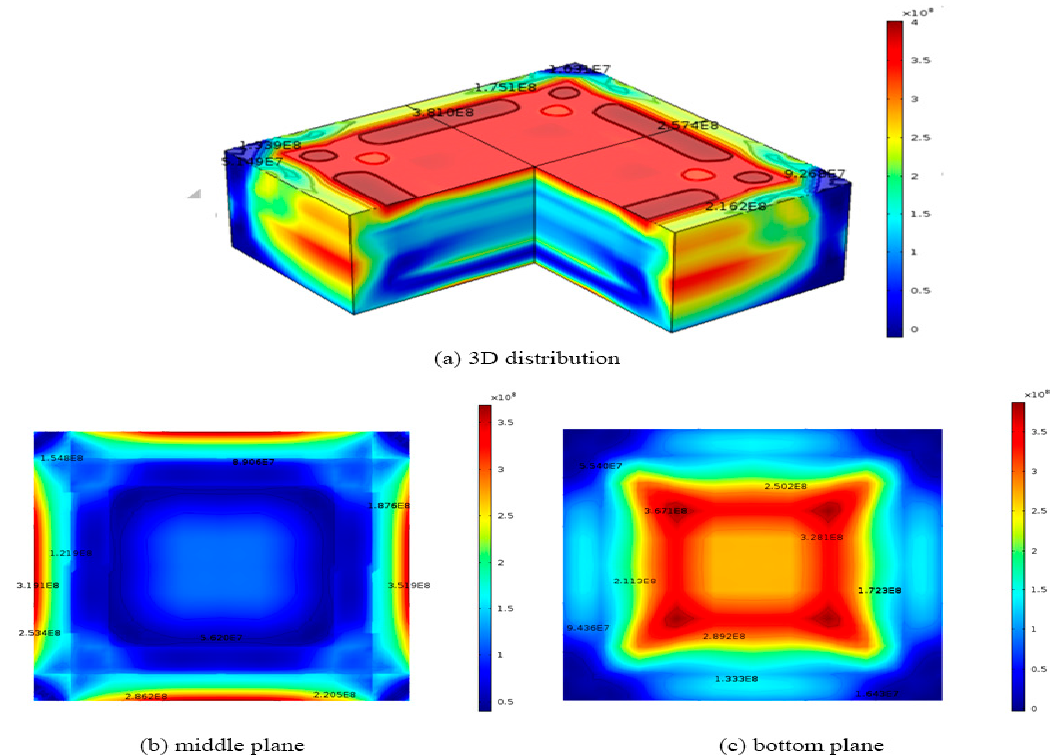
Figure 4. Dislocation density distributions of 0.84 m × 0.84 m × 0.3 m ingot at the end of the cooling process obtained from Hassen model with the original cooling process ( a ) 3D distribution; ( b ) middle plane; ( c ) bottom plane.